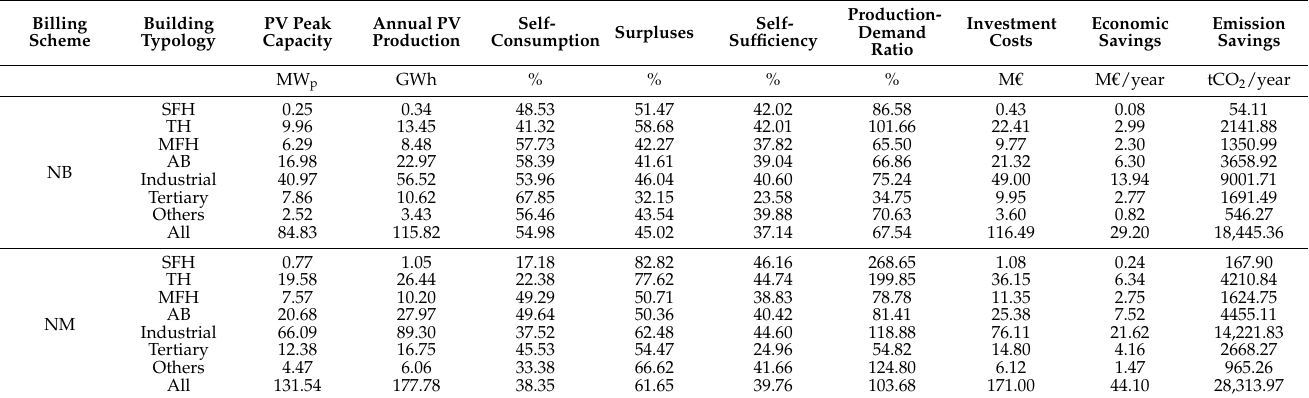
Table 8. Overall PV potential of the